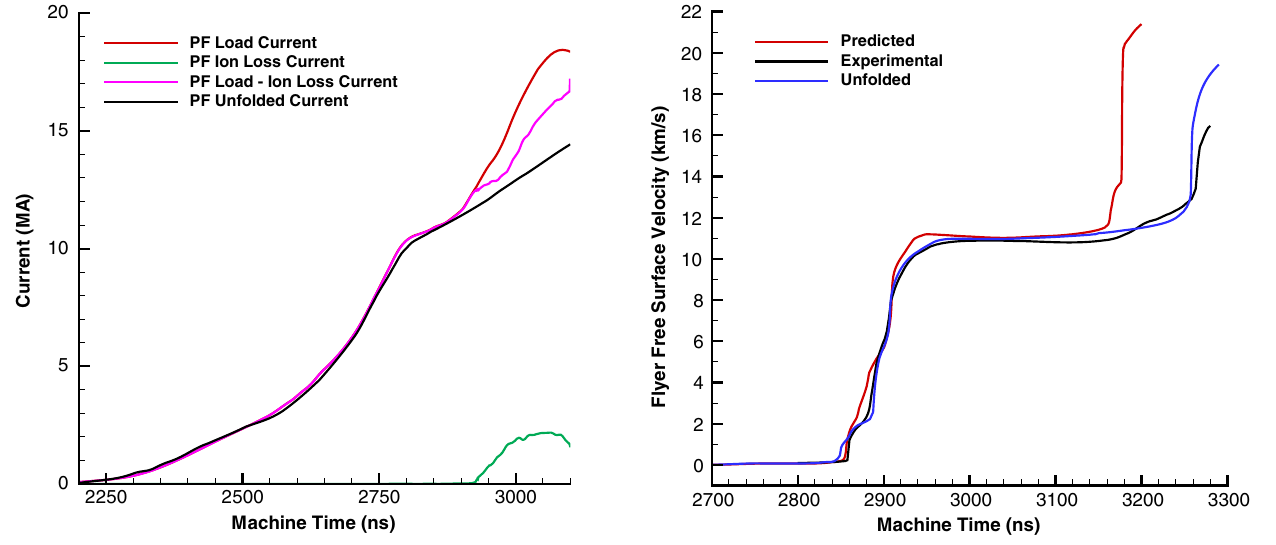
FIG. 7. Relevant velocities for the load current unfold for Z3260. The predicted flyer free surface velocity is shown in red. The experimental velocity (black) indicates significant loss after the shock hold. The velocity resulting from the best solution unfold is shown in